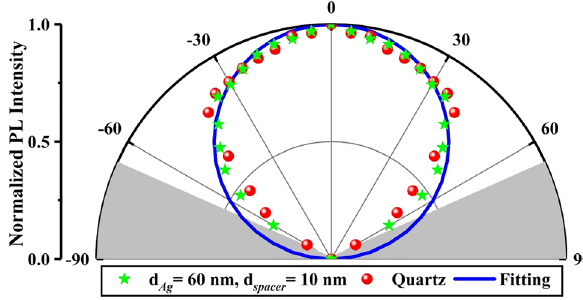
Figure 4: The angle-resolved fluorescence